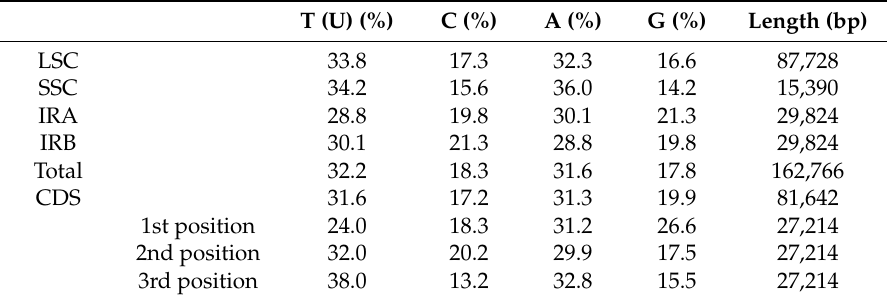
Table 1. Base composition in the Amomum kravanh chloroplast